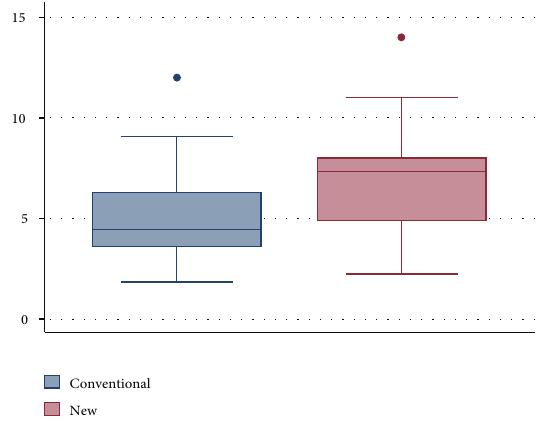
Figure 7: Percent milk